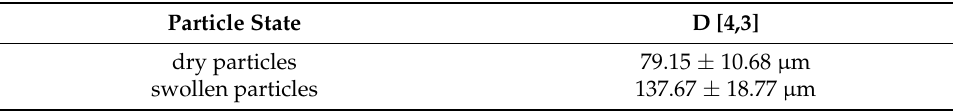
Table 2. Average particle size of dry and swollen